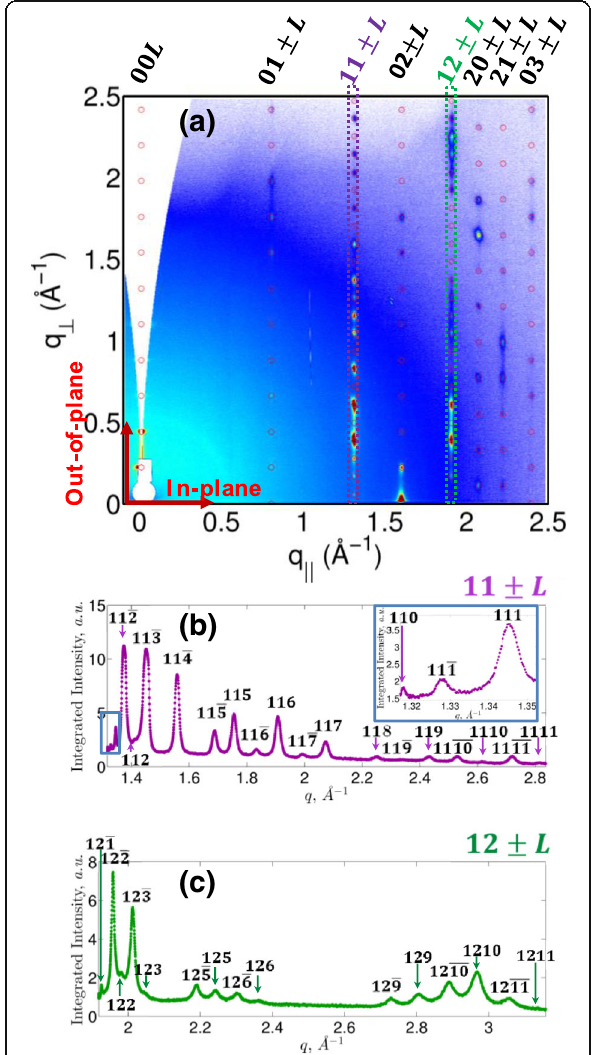
Fig. 1 a 2D-GIXD patterns of the highly crystalline vacuum- deposited DH4T film with overlaid simulated Bragg reflections (red circles) for a monoclinic unit cell. Intensity line profiles measured along q ⊥ of b 11 ± L and c 12 ± L reflection families are given in purple and green color,